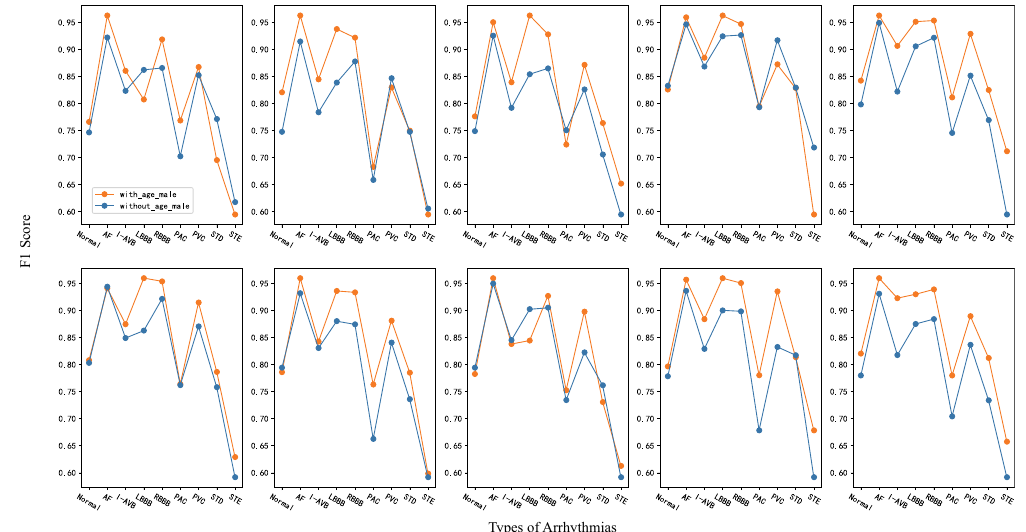
Figure 3. Compare the F 1 scores of the models with and without age and gender. The 10 subgraphs used models with different hyper-parameter combinations. Table 2 shows these hyper-parameter